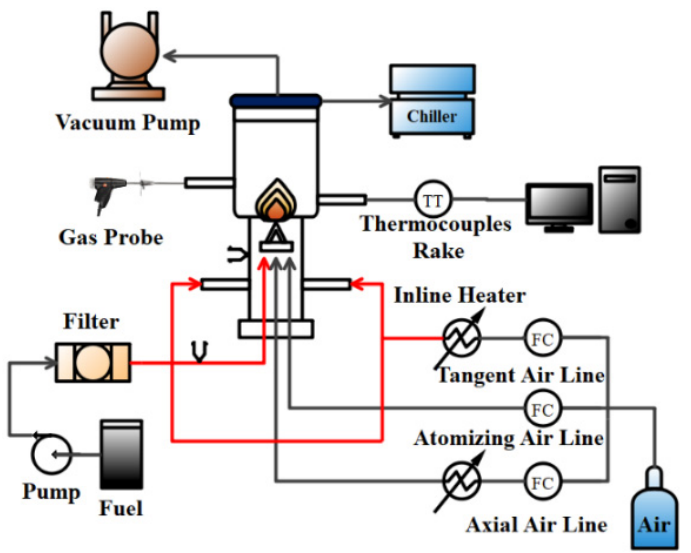
Figure 5. Experimental apparatus.